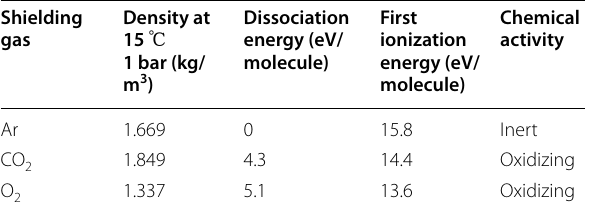
Table 2 Chemical and physical properties of gases used in pulsed current NG-GMAW Shielding